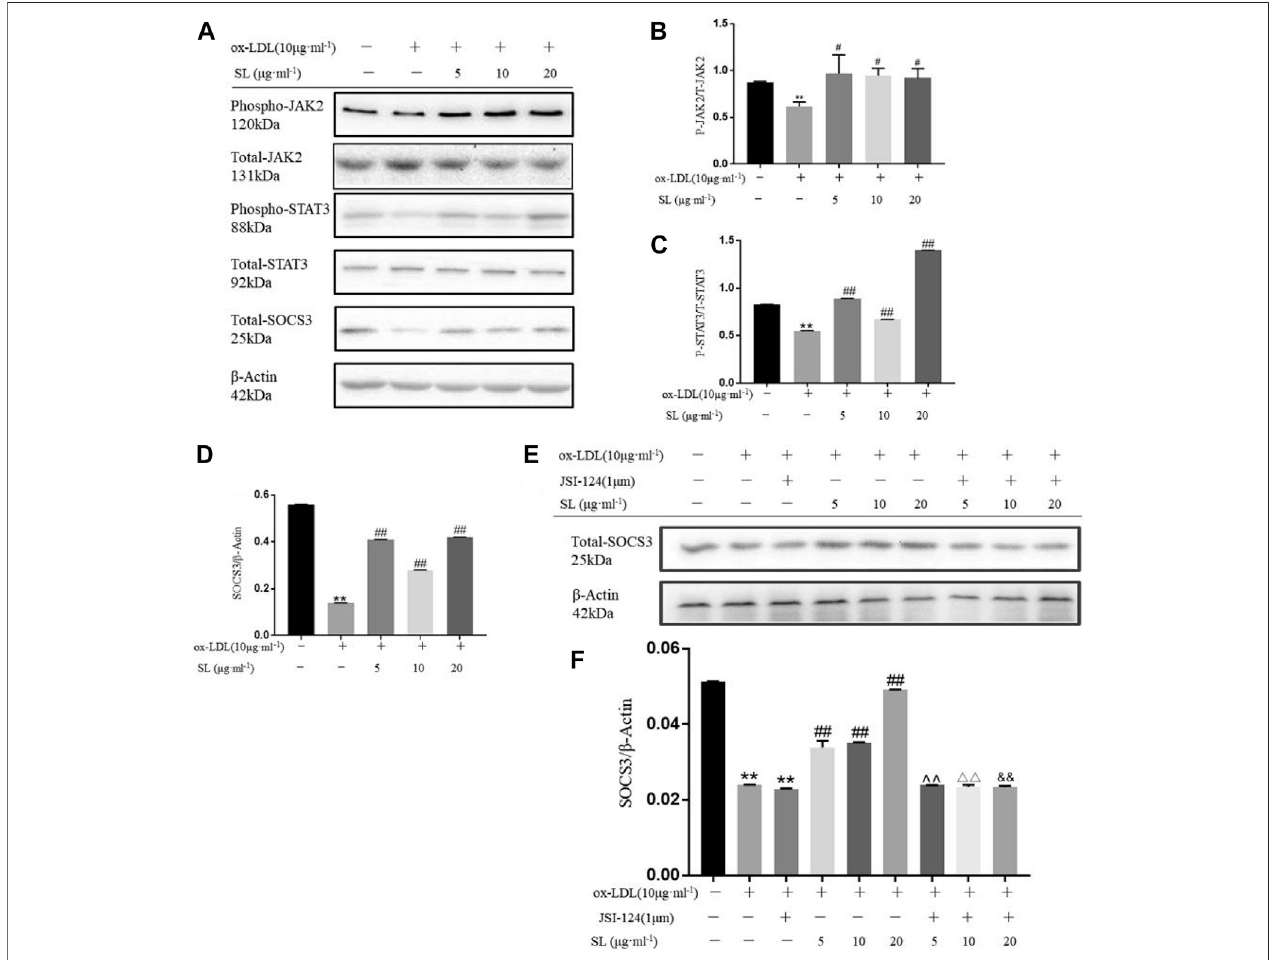
FIGURE 2 | Transformation of macrophage phenotype induced by SL involves STAT3/SOCS3 pathway . (A – D) Detection of the phospho-JAK2, total-JAK2, phospho-STAT3, total-STAT3, total-SOCS3 and β -actin in SL-treated macrophages for 24 h, n (cid:2) 3. (E,F) After speci fi c blockading of JAK/STAT3 by JSI-124, total SOCS3 expression was detected by western blotting, n (cid:2) 3. * p < 0.05 and ** p < 0.01 compared to the untreated group, and # p < 0.05 and ## p < 0.01 compared to control groups treated with ox-LDL, ^^ p < 0.01 compared with the SL-5 group, △△ p < 0.01 compared with the SL-10 group, and && p < 0.01 compared with the SL-20